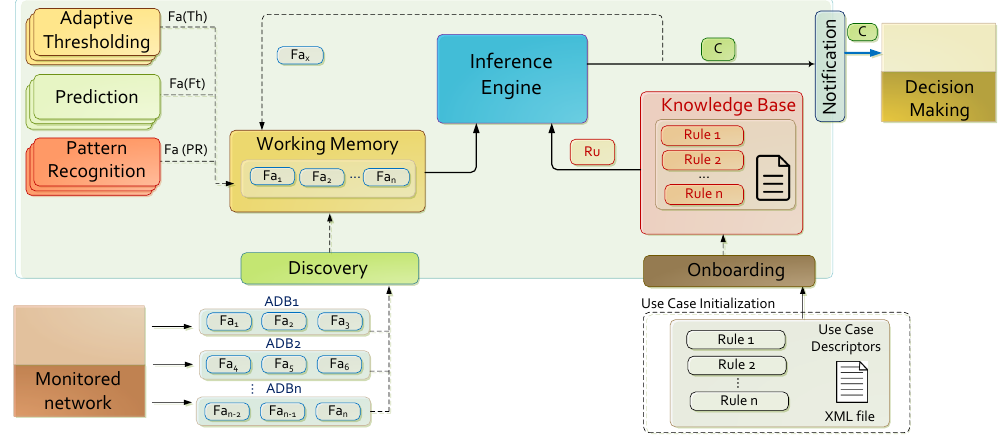
Figure 2. Knowledge acquisition framework for 5G